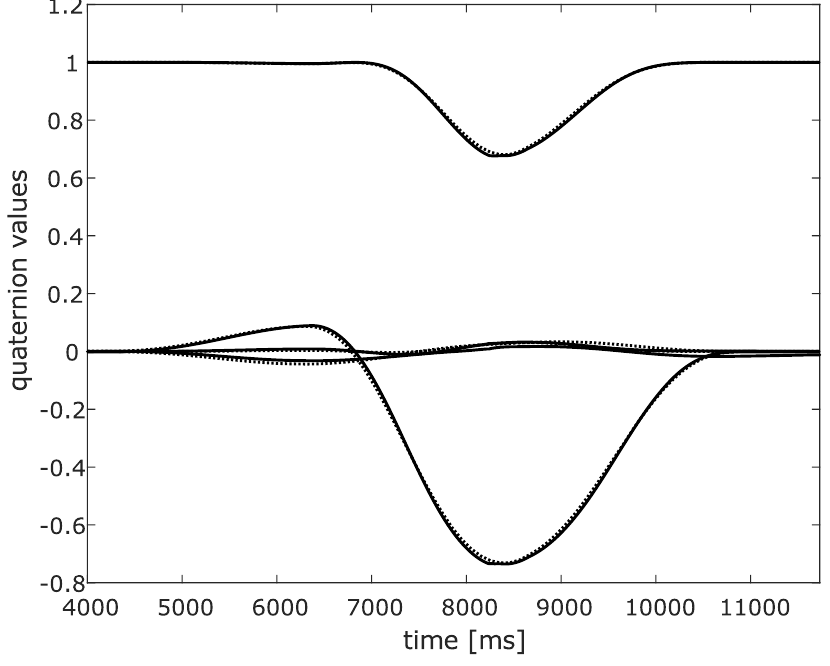
Figure 5. Quaternion values of the lower leg analogue of the RTS filtered IMU data (full lines) and robot logged values (dashed lines).